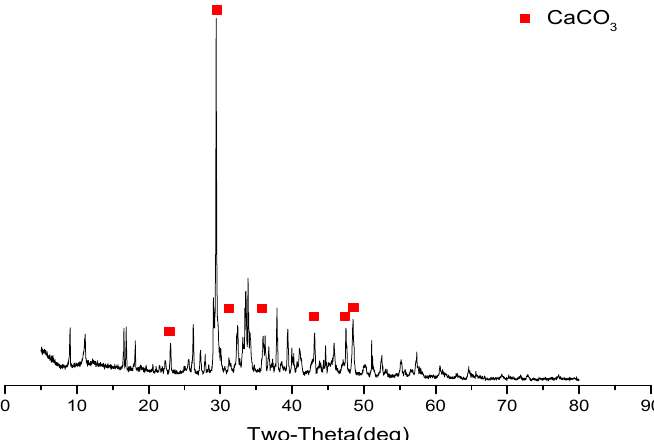
Figure 4. XRD analysis of cathode side leachables (mix ratio of no. 2 in Table 6, at 120 d). The reaction occurs on the cathode side of the stray current device, as shown in Equation (1):